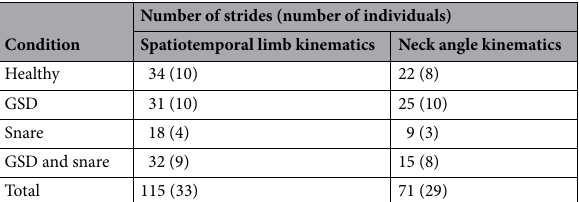
Table 1. Number of strides and individuals for different condition categories in free-ranging Nubian giraffe Giraffa camelopardalis camelopardalis from Murchison Falls National Park, Uganda.